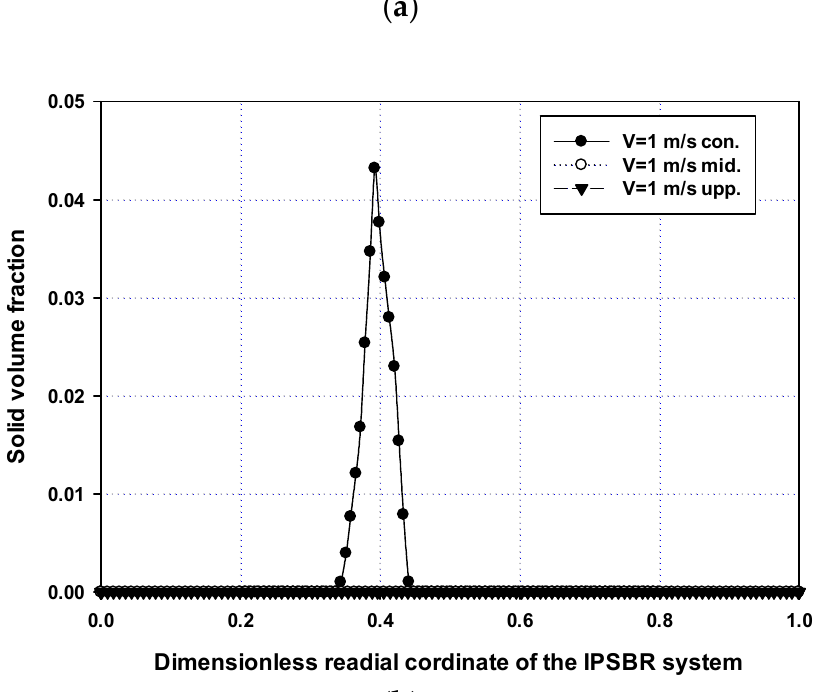
at a constant orifice diameter of 0.003 m, gas head of 0.25 m, mixing particle diameter of 0.0135 m,